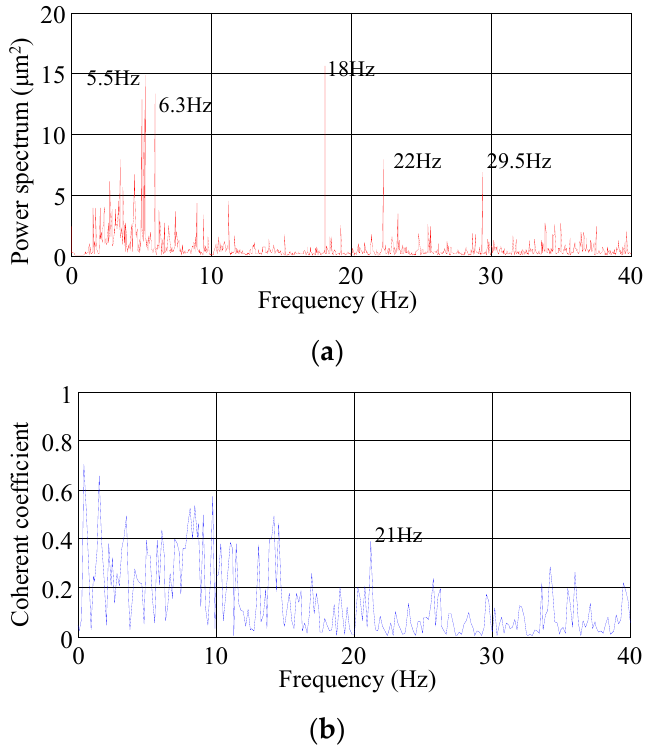
Figure 8 are the MP-FRF and its coherence coefficients. In Figure 8b, all coherence